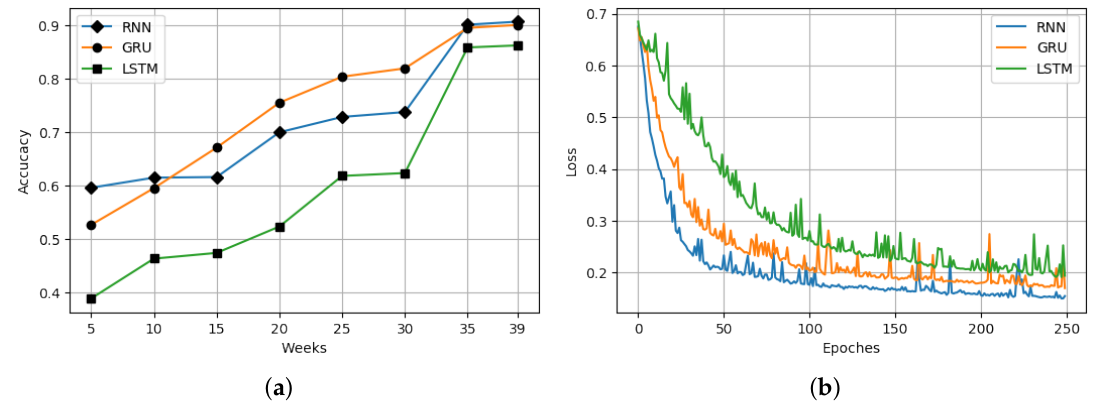
Figure 3. Averaged prediction results over all courses for all weeks. ( a ): Averaged testing accuracy for all models across weeks; ( b ): Averaged loss value of all models across 250